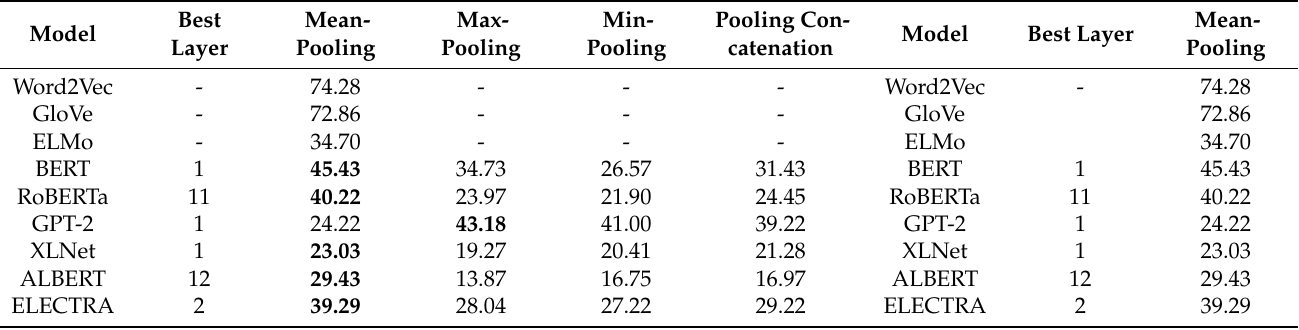
Table 2. Mean V-measure scores (in %) of the examined models for sentence